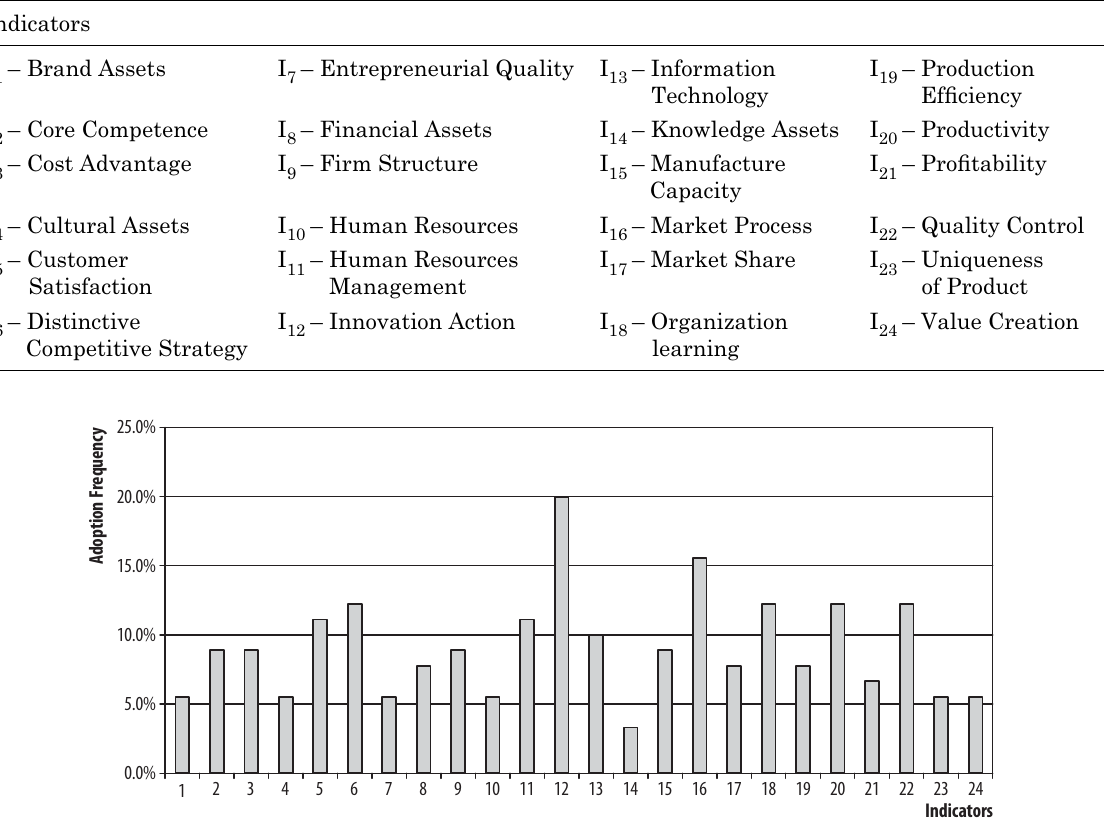
Figure 1. The adoption frequency of competitiveness indicators in the literatures